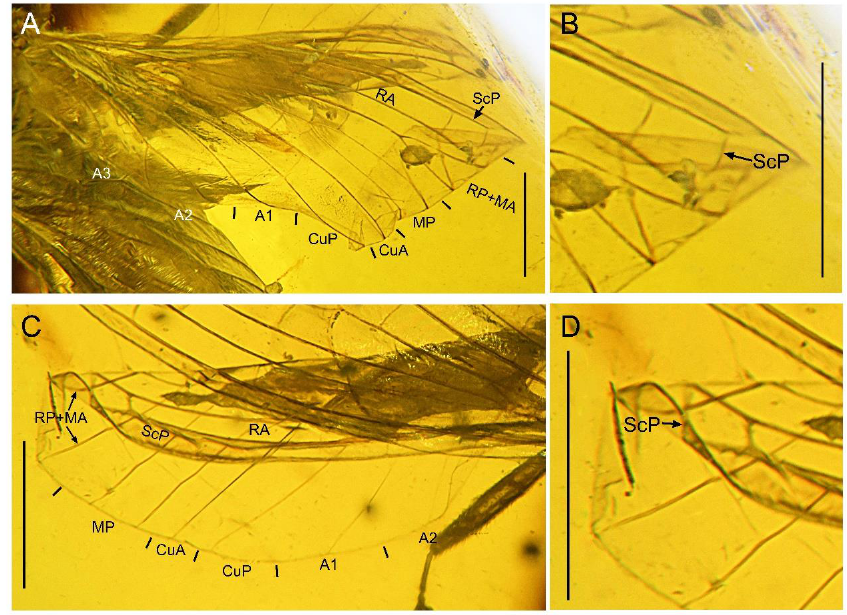
Figure 2. Paradoxoconis szirakii gen. et sp. nov. , holotype: NIGP 180659. ( A ) Right forewing; ( B ) antero-distal part of right forewing; ( C ) right hind wing; ( D ) antero-distal part of right hind wing. Scale bar = 1.0 mm.